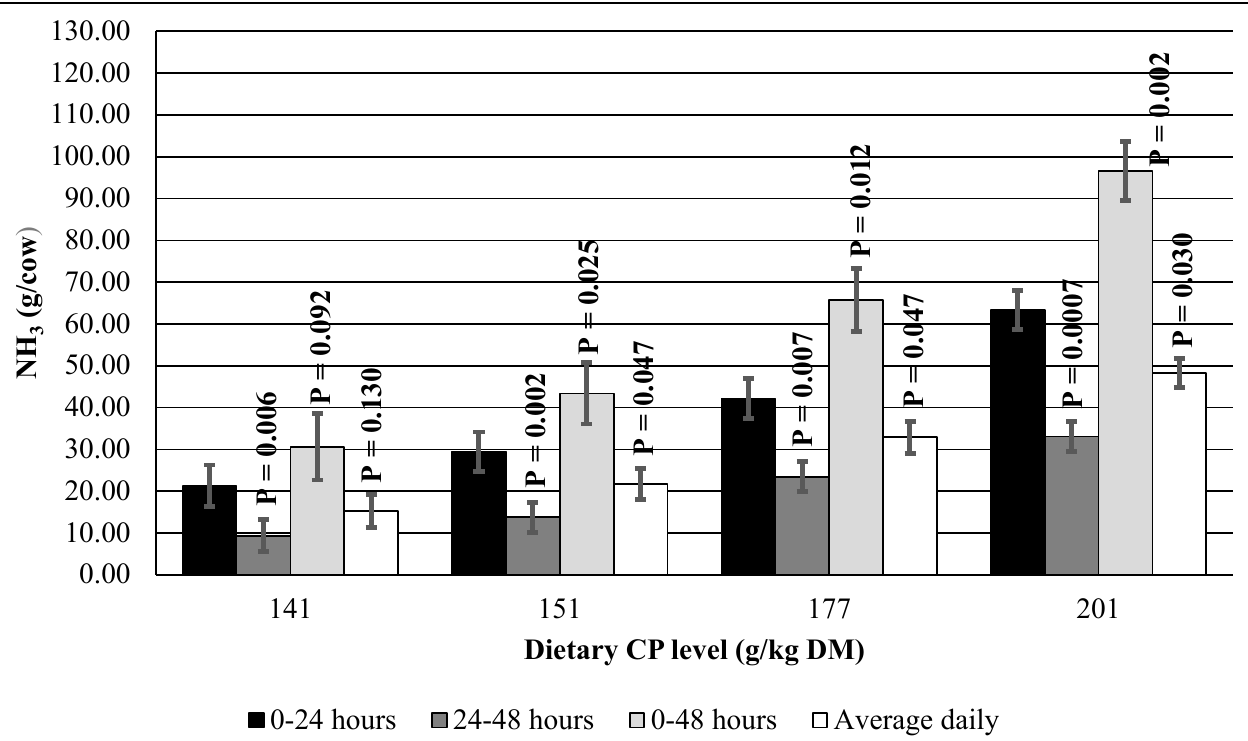
Figure 2. NH 3 emissions from slurry from lactating cows fed at 4 dietary CP levels (141, 151, 177, and 201 g CP/kg DM) measured at different time intervals (0–24, 24–48, and 0–48 h) in open-circuit respiration chambers. The figure presents 24–48 and 0–48 h averages, as well as daily averages compared with the 0–24 h averages (within dietary CP levels) using the two-sample t -test. Vertical bars represent standard errors of the means.